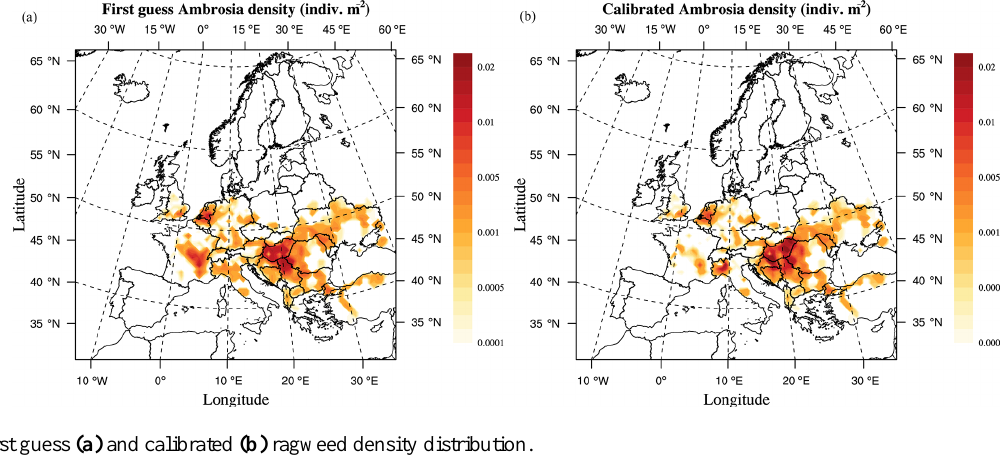
Figure 3. First guess (a) and calibrated (b) ragweed density distribution.